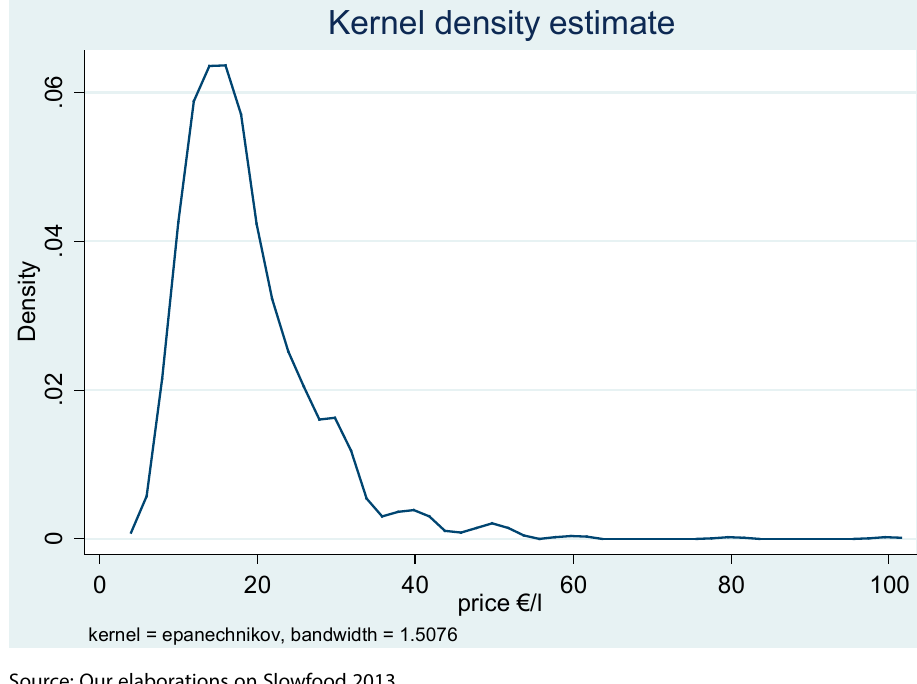
Figure 1. Prices